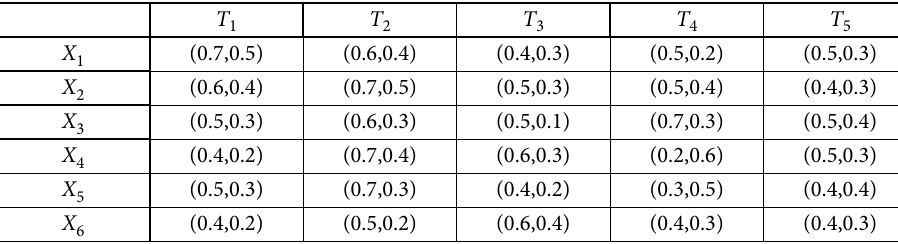
Table 2. Decision matrix with q-ROFNs by the second expert T